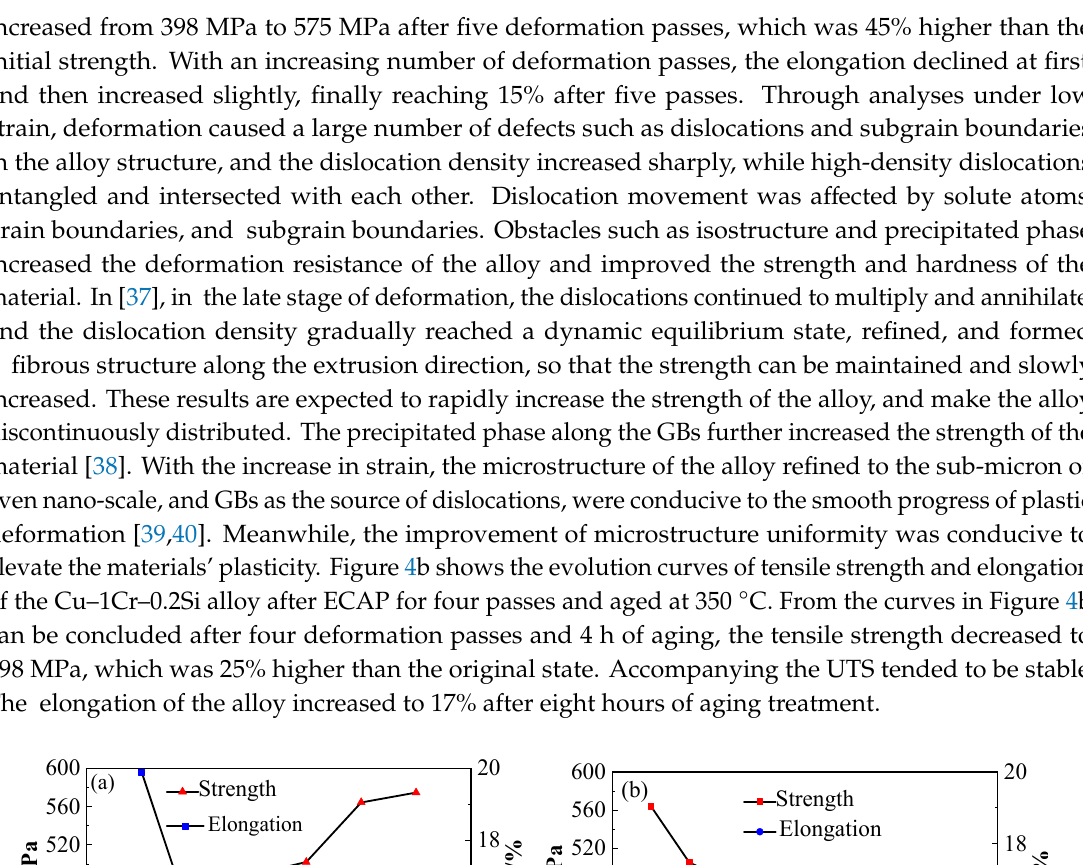
Figure 5. Electrical conductivity of Cu–1Cr–0.2Si alloy. ( a ) ECAP deformation of one to eight passes and ( b ) aging treatment at 350 °C for 8 h. 4. Discussion 4.1. Mechanical Properties During ECAP deformation through the route Bc, the microstructure of the Cu–1Cr–0.2Si alloy was gradually refined into a fibrous structure, and then distributed along the extrusion direction. The high-density dislocations introduced by the deformation and lots of unstable subgrain boundaries and GBs caused by deformation lead to a continuous increase in lattice distortion energy, leading to an increase in the resistance of the free electrons to move, as shown in Figure 5a, resulting in a slight decrease in the electrical conductivity. The effect of temperature-rise led to the precipitation of a large number of enhanced phases near the GBs and deformation zones, pinning dislocations and increased lattice distortion, and some irregular Cr phases further increased the lattice mismatch between the matrix and the heterogeneous interface. The precipitated phase caused by ECAP deformation was mainly distributed near the GBs and the deformation bands hindered the movement of dislocations, which is conducive to increasing the strength and decreasing the elongation continuously. In the early stages of aging treatment, dislocations annihilated, and work hardening was gradually eliminated. The continuous increase in the precipitated phase led to the increase of dislocation movement resistance, thereby further maintaining the strength of the alloy and partially recovering